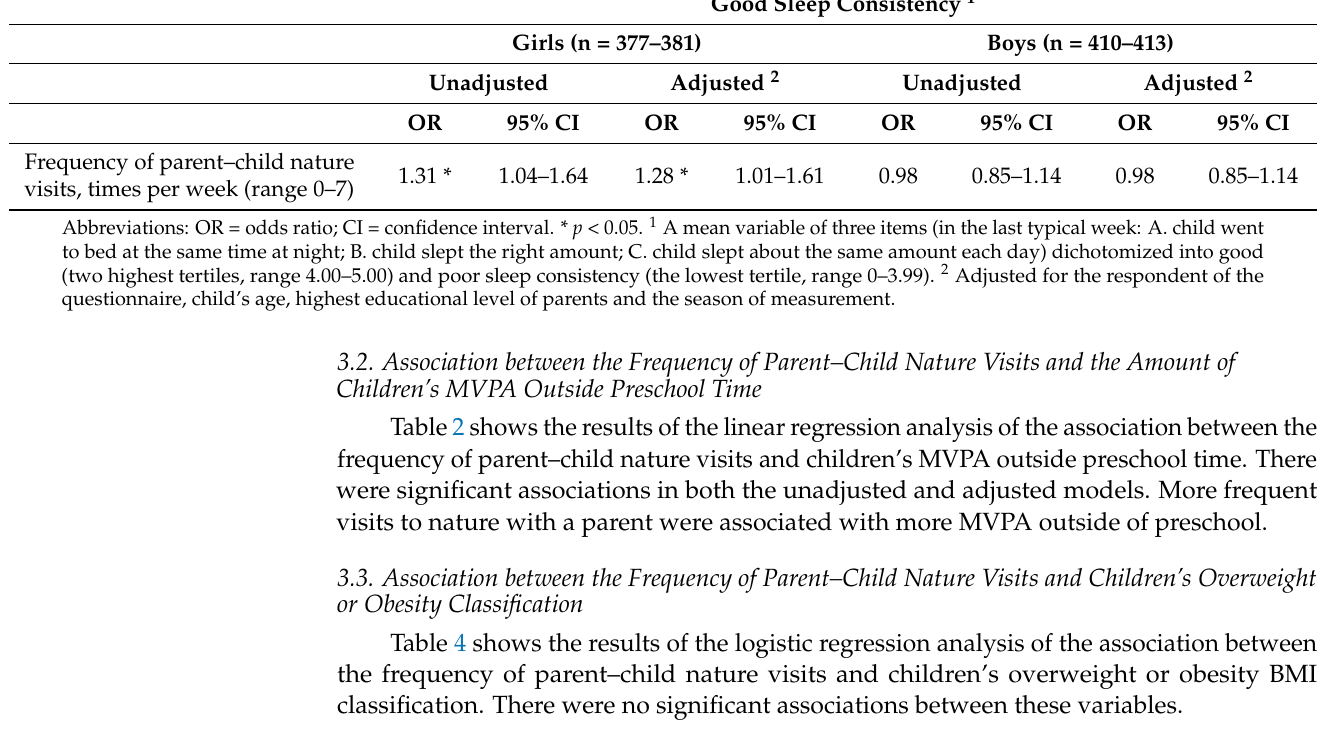
Table 4. Logistic regression analyses of the associations between the frequency of parent–child nature visits per week and children’s overweight or obesity BMI